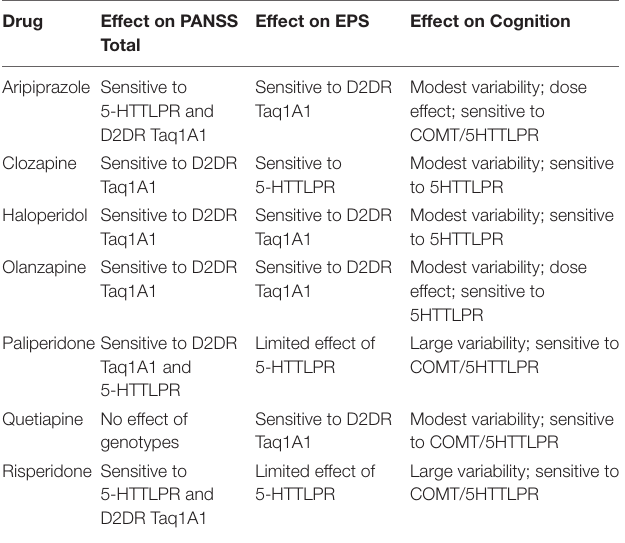
TABLE 3 | Overview of the sensitivities of clinical outcomes with individual antipsychotics at most relevant clinical dose to single genotypes in patients with